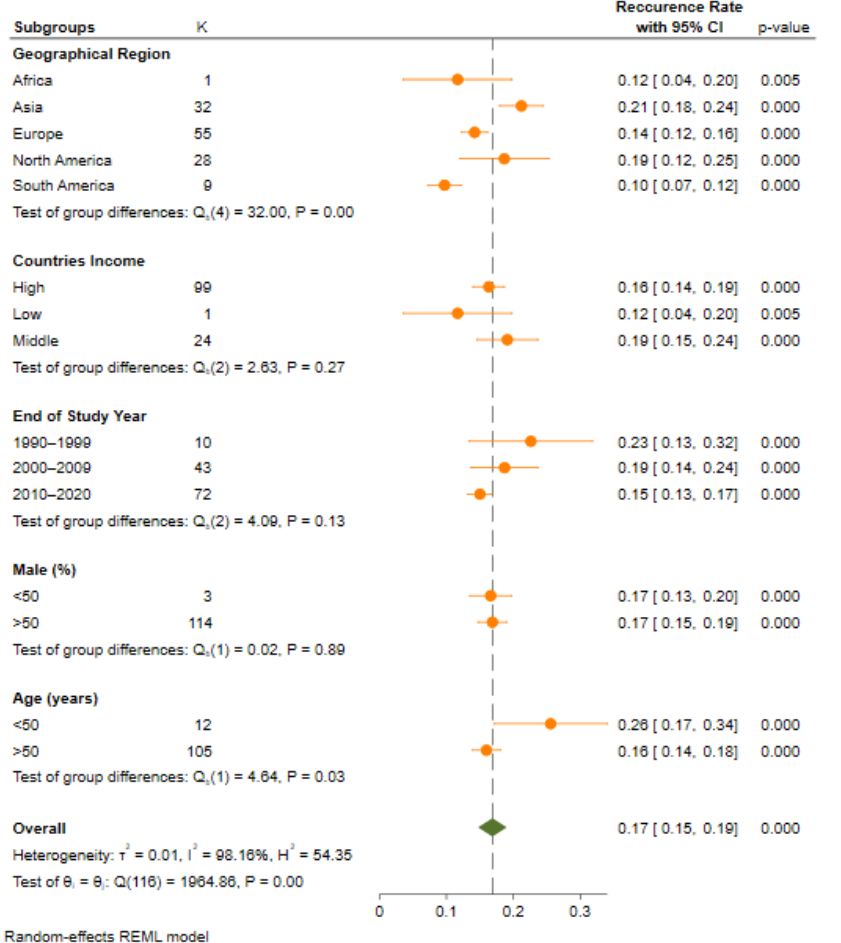
Figure 2. Pooled prevalence of HCC recurrence of all included studies.